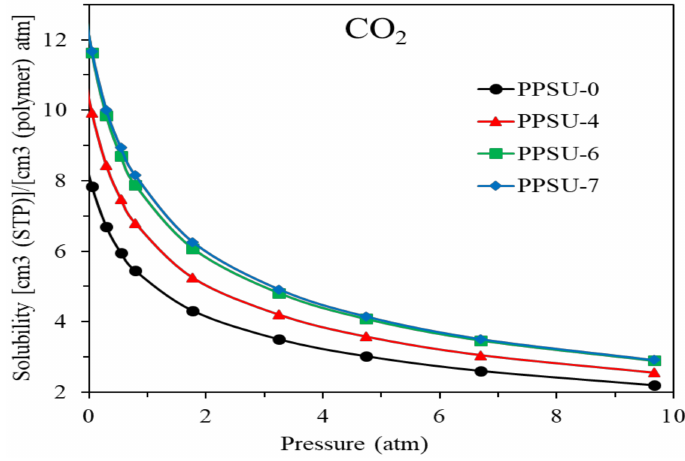
Figure 11. Solubility coefficient of CO 2 as a function of pressure for PPSU-0, -4, -6, and 7.